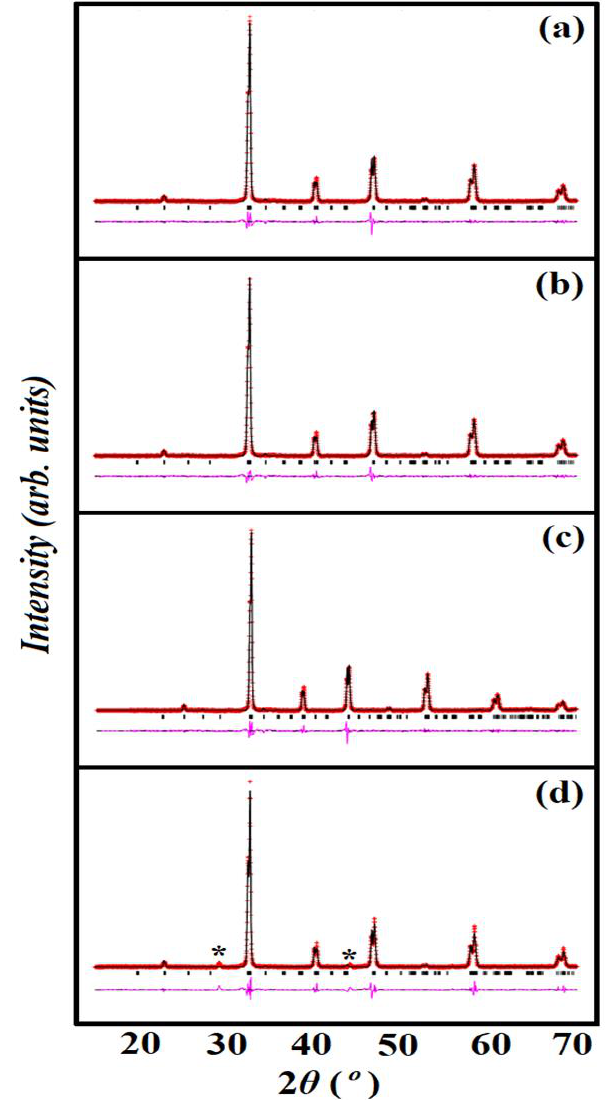
Figure 2. Rietveld refinement of XRD pattern of ( a ) STC, ( b ) STCM3, ( c ) STCM5 and ( d ) STCM7 samples. Black solid lines are observed data, the red solid line is the calculated pattern, and the pink solid line is the difference. Small black vertical tick marks above the difference plot denote the Bragg peak positions. The “ * ” mark indicates cobalt impurity phases presence in the sample.